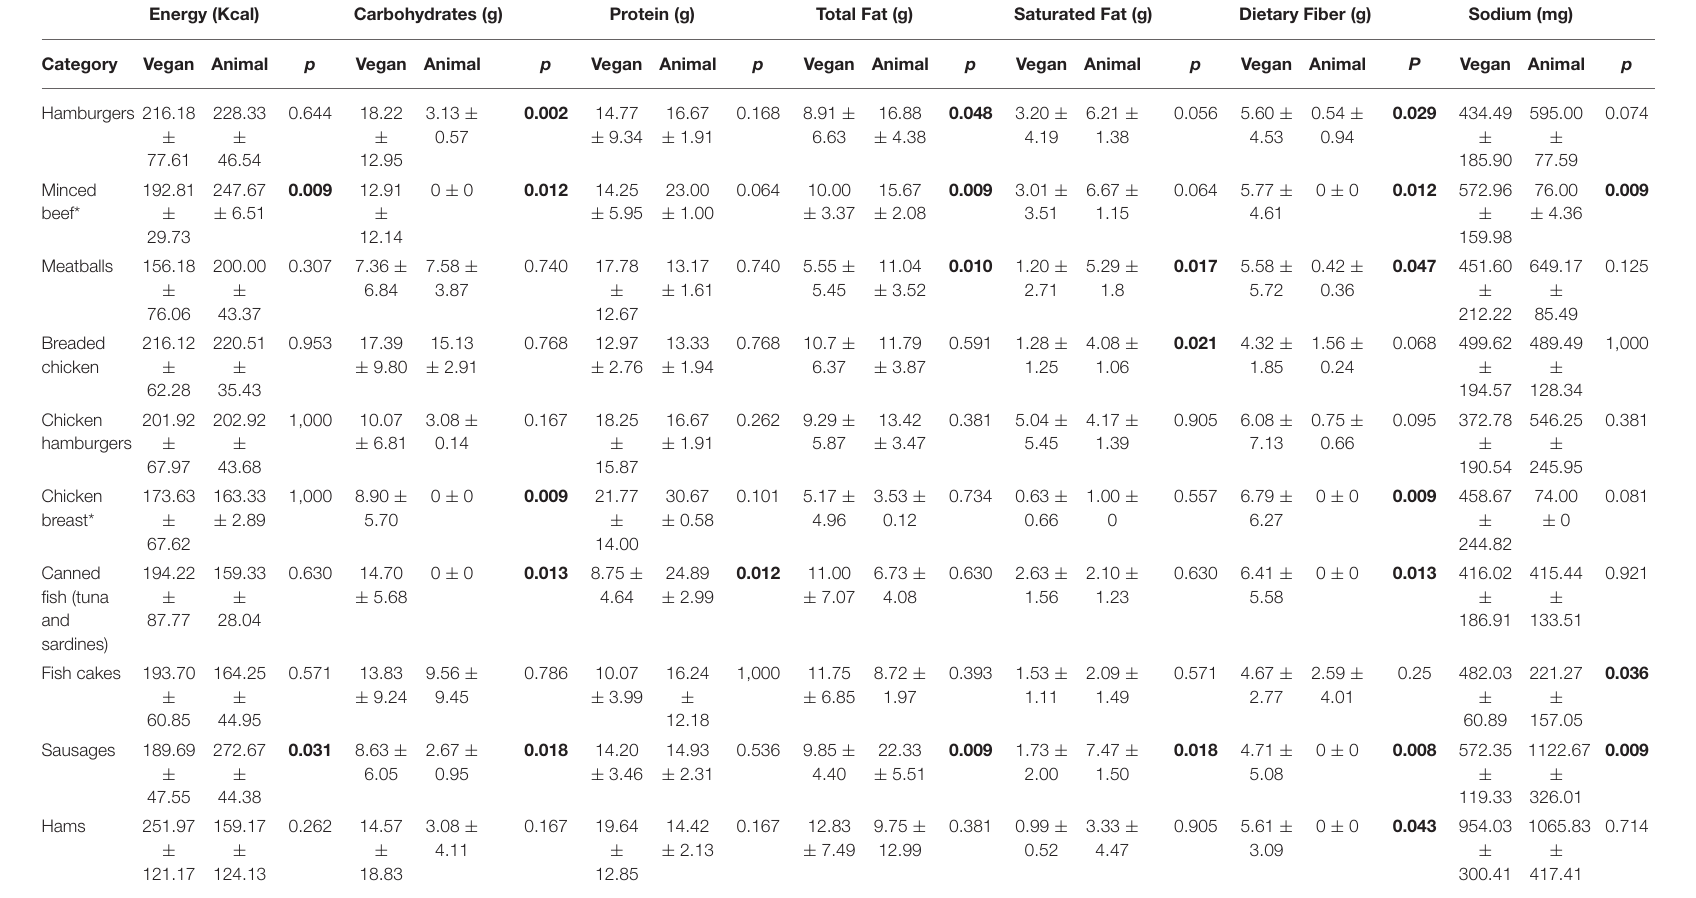
TABLE 1 | Means and standard deviations of the nutritional values per 100g of serving of the included